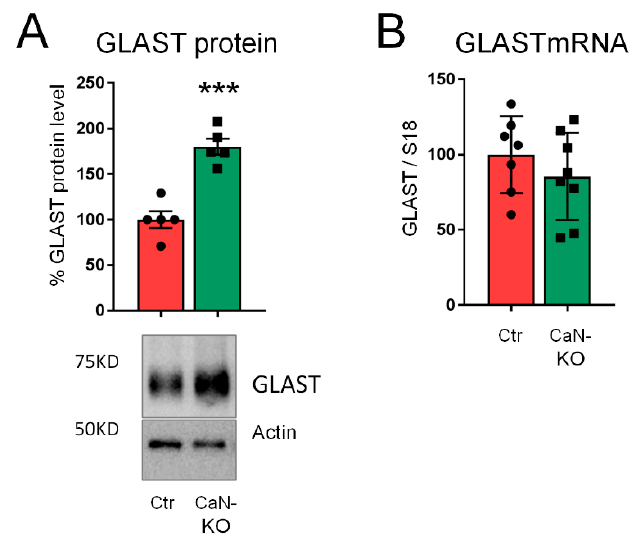
Figure 5. GLAST protein, but not mRNA, is upregulated in hippocampal synaptosomes from astroglial CaN-KO mouse. ( A ) GLAST protein expression in hippocampal synaptosomes from control (Ctr) and astroglial CaN-KO mice (CaN-KO). Data are expressed as mean ± SD, 5 independent synaptosomal preparations, each of which was a pool from two animals, were used for both Ctr and CaN-KO. *** p < 0.001, unpaired two-tailed Student’s t-test. ( B ) Real-time PCR of GLAST from hippocampi of Ctr and astrocytic CaN-KO mice. Values represent mean ± SD ∆ C(t) of gene / S18 of 7 independent samples for each genotype.